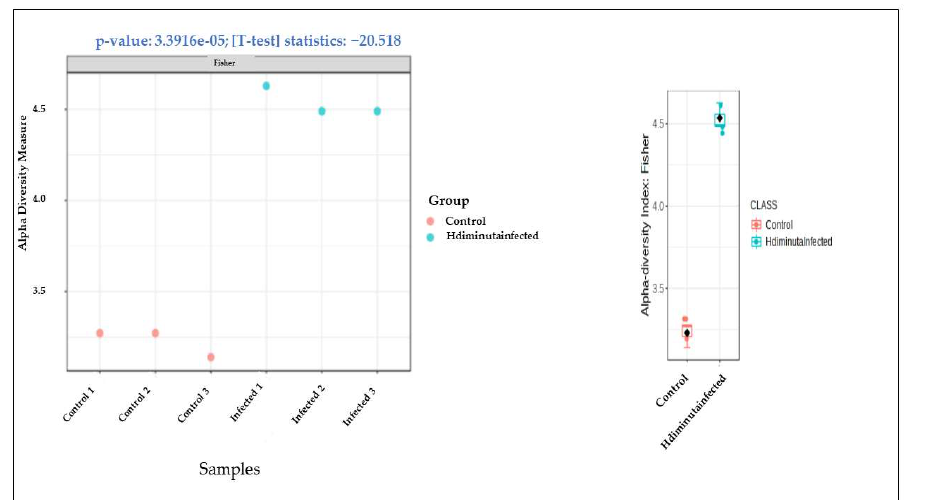
Figure 5. Metagenomic analysis of functional alpha diversity of gut microbiota of Control (3 replicas-Control 1, 2 and 3) and Infected (3 replicas- Infected 1, 2 and 3) samples ( a ) Chao1 alpha diversity measure and index ( b ) Shannon alpha diversity measure and index ( c ) Simpson alpha diversity measure and index ( d ) Fisher alpha diversity measure and index.